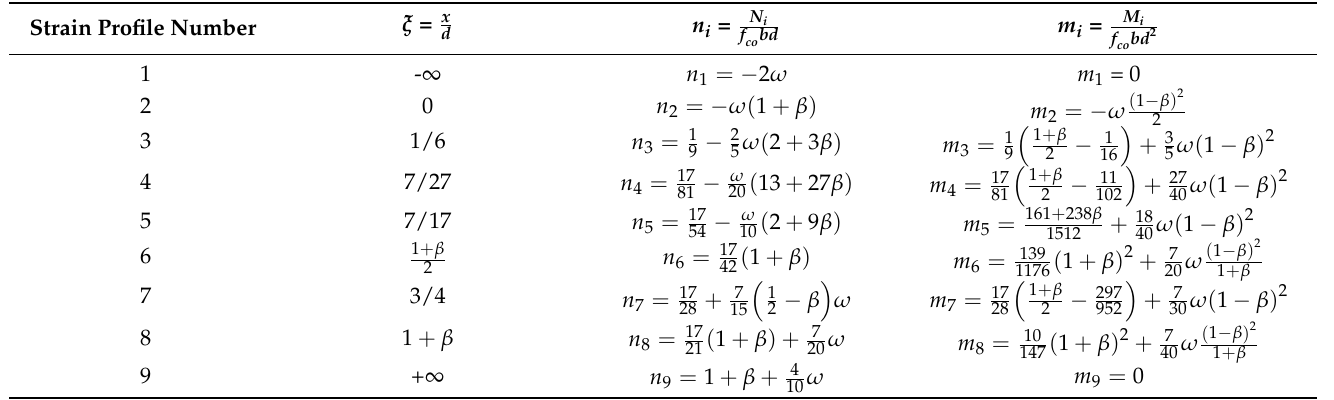
Table 1. The coordinates of the points on the interaction curve